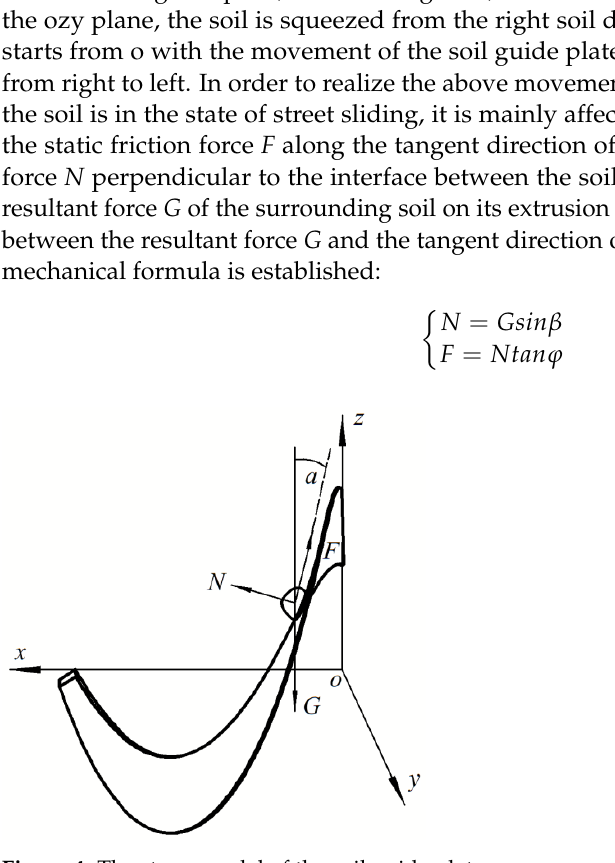
Figure 4. The stress model of the soil guide plate.